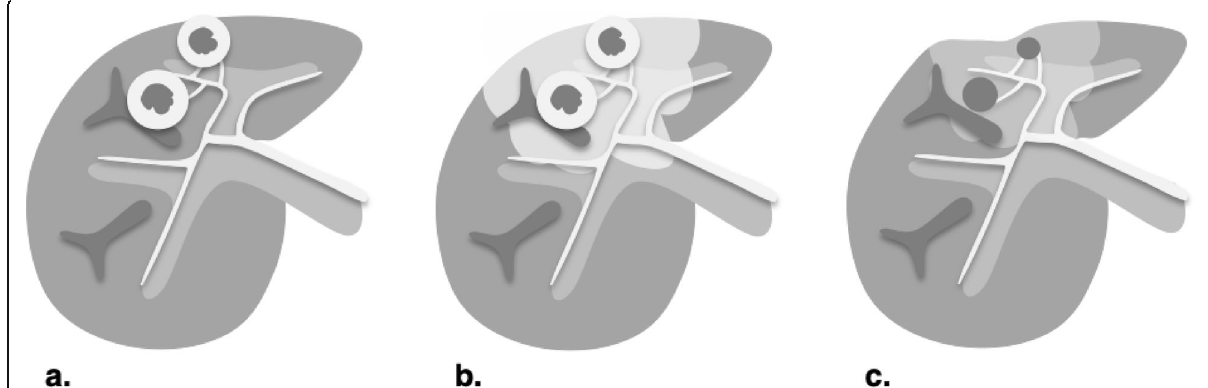
Fig. 28 Expected treatment response after stereotactic body radiotherapy (SBRT) and transarterial radioembolization (TARE). Axial